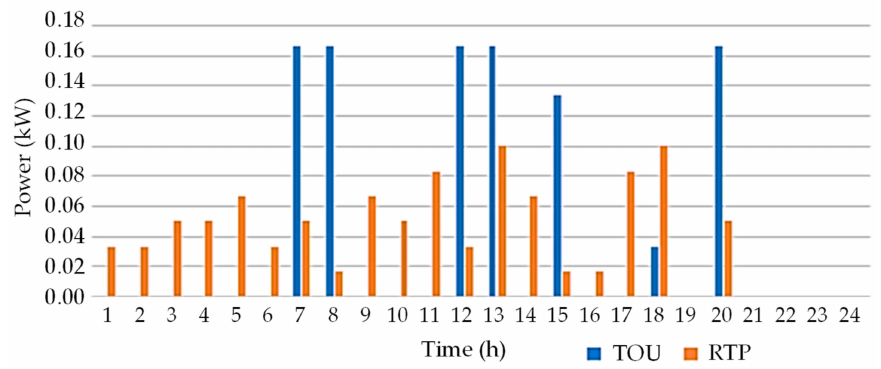
Figure 17. Energy consumed by the sanitarian water heater system: Comparison between tari ff s schemes; the best